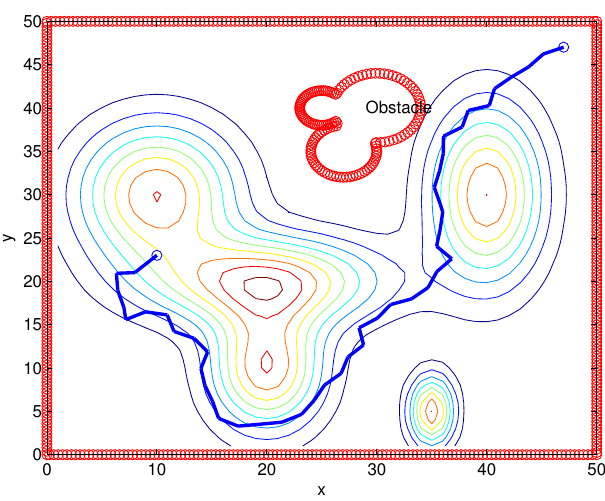
Figure 8. One route constructed under one MC simulation of the RRT ∗ (Scenario 2). The generated route is marked with blue line